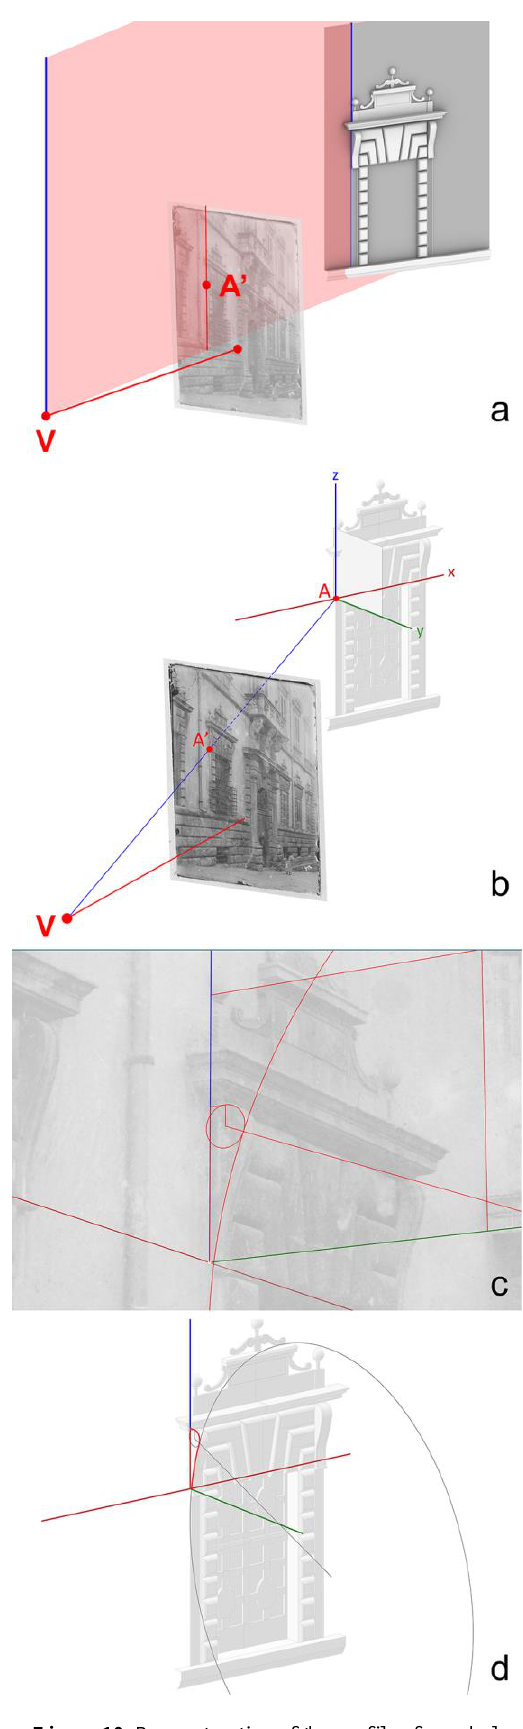
Figure 10 . Reconstruction of the profile of a